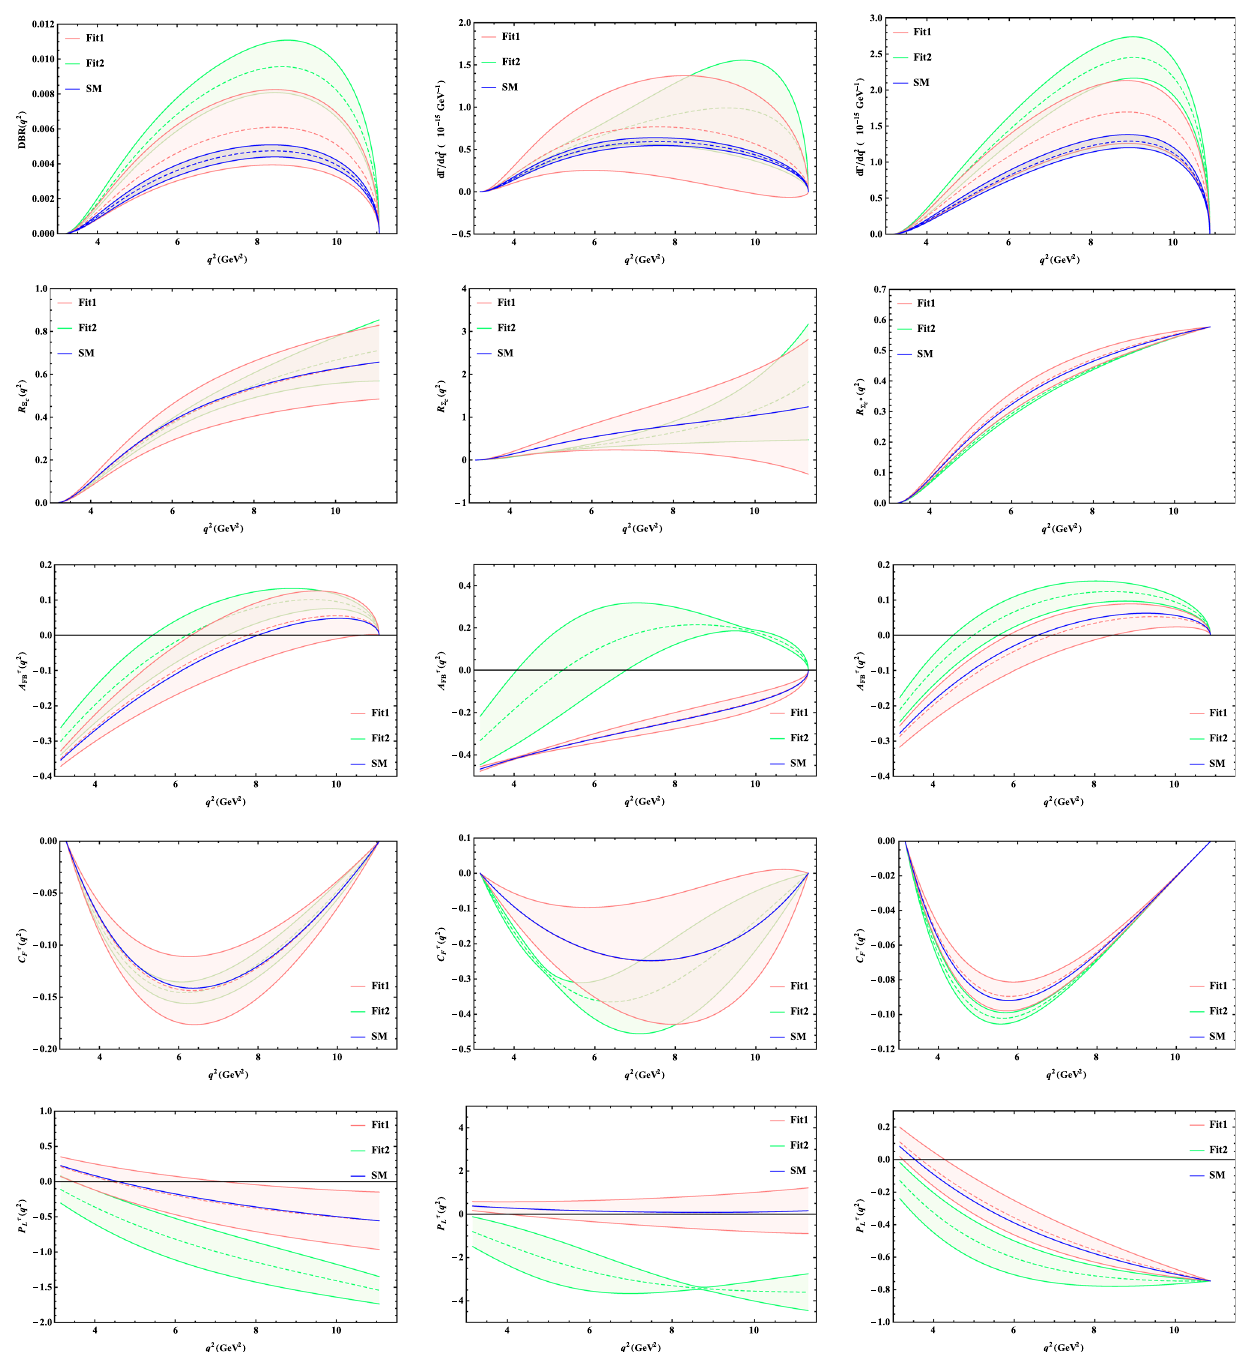
Fig. 5 SM and NP predictions of various q 2 -dependent observables for the Ξ b → Ξ c τ − ¯ ν τ (left panel), Σ b → Σ c τ − ¯ ν τ (central panel) and Σ → Σ ∗ τ − ¯ ν τ (right panel) decay modes using Fits 1 and 2 of [54] b c for Ξ b → Ξ c τ − ν τ decay. It shifts to a higher q 2 value in case of both the scalar couplings. The deviation from the SM prediction is more prominent at large q 2 . For Σ b → Σ c τ − ν τ ( q 2 ) shows a distinct deviation from the SM pre- decay, P τ L diction in the case of the scalar couplings. Thus, measuring